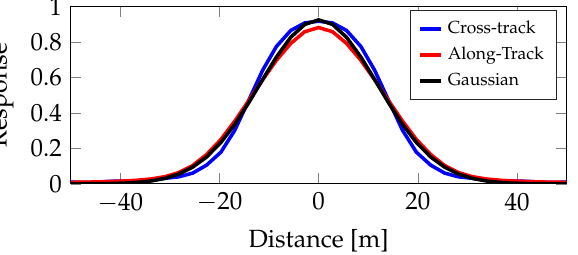
Figure 2. The PSF of the Landsat 8 OLI band 6 and the estimated Gaussian function. Another issue with sharpening the L8 images was that the SLSharp method was